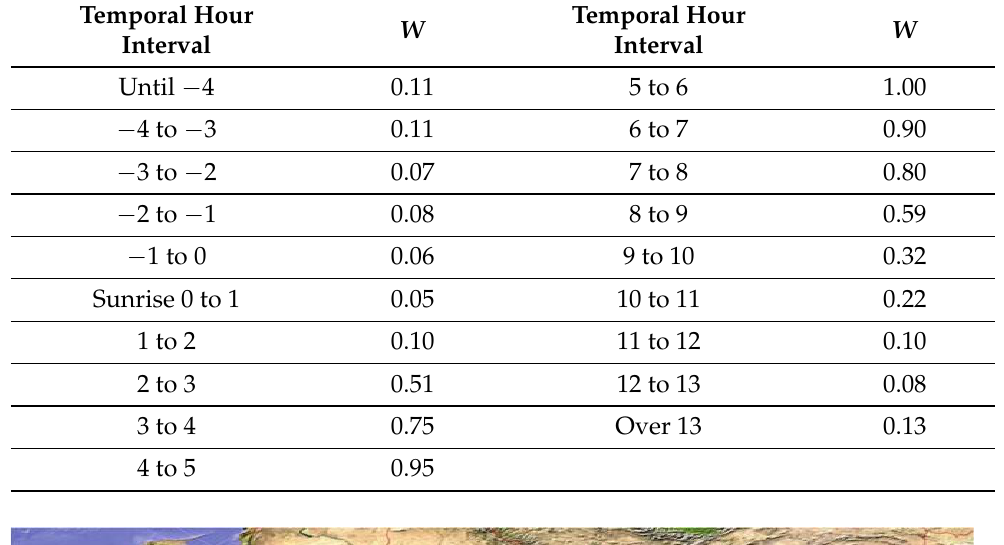
Table 1. Weight Function [48].